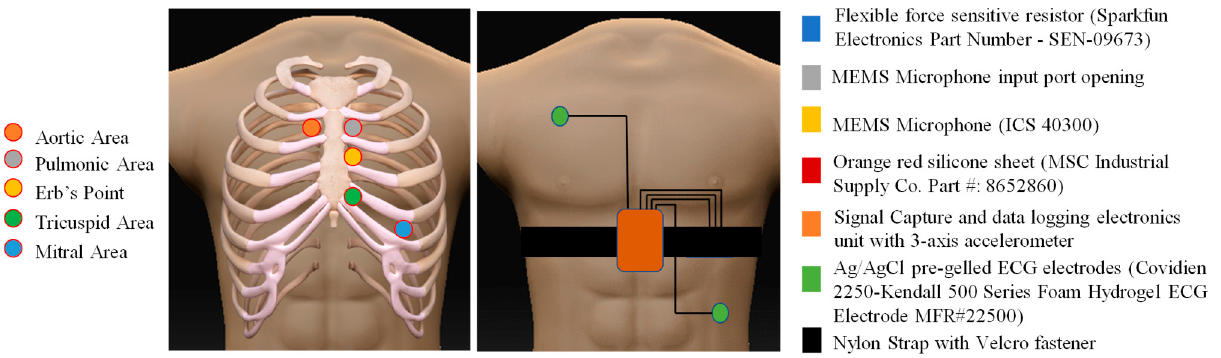
Figure 2. On the left, illustration of the standard clinical auscultation placements on the thorax; right, the positioning of the electrodes and sensing element of the WPAS system.